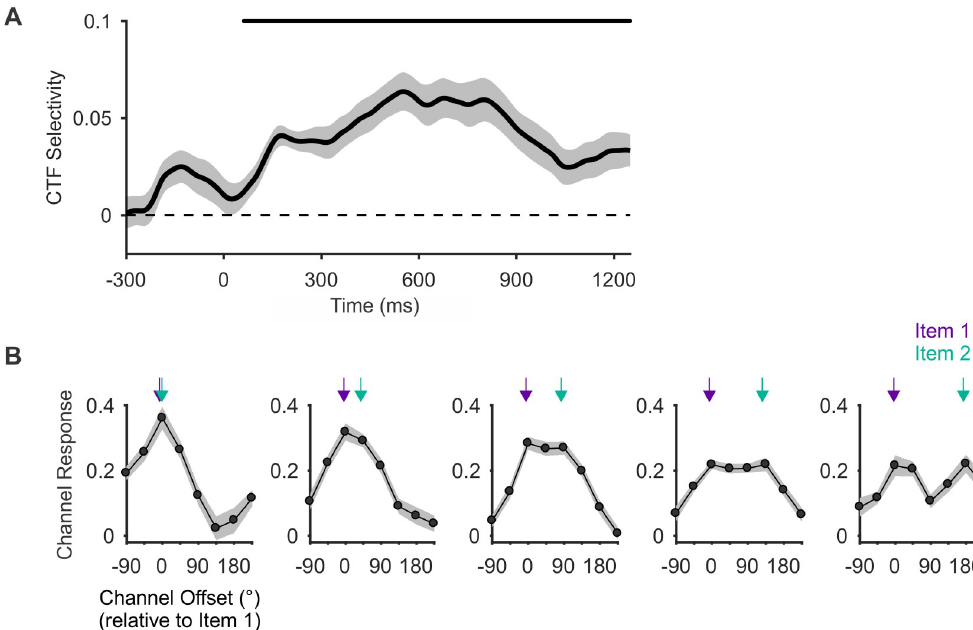
Fig 4. Testing whether multivariate patterns of alpha-band power generalize between one-item and two-item trials. (A) The spatial selectivity of alpha-band CTFs across time (measured as CTF slope; see Materials and methods) in the two-item condition when the IEM was estimated using the one-item condition. The markers at the top of the panel indicate the period of above-chance selectivity obtained using a cluster-based test. (B) Mean delay-period (averaged from 250–1,250 ms) channel-response profiles as a function of the distance between the items. The arrows above each subplot mark the channel (s) tuned for the positions of the 2 stimuli. The shaded error bars reflect ± 1 SEM across observers. Data are available at https://osf.io/47cmn/. CTF, channel-tuning function; IEM, inverted encoding model.